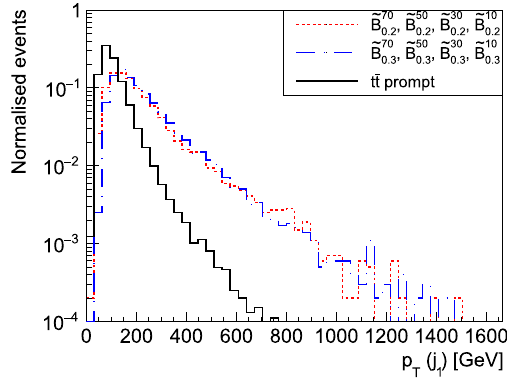
Fig. 13 Transverse impact parameter d 0 of the top quarks in the ˜ B -like = 200 GeV case with m ˜ χ 0 1